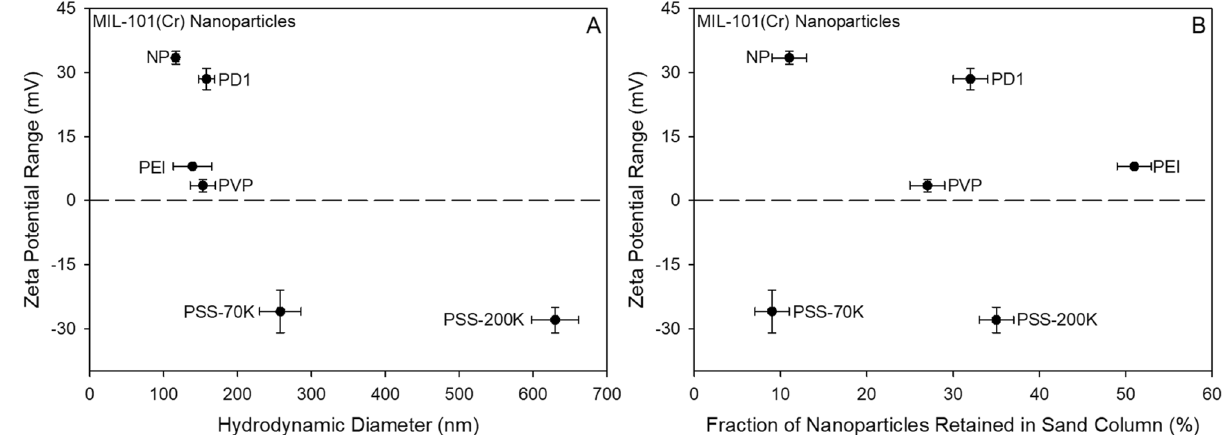
Figure 3. ( A ) Zeta potential ranges and hydrodynamic radii of synthesized MIL-101(Cr) MOF nanoparticles and polymer-coated MOF nanoparticles at an unadjusted pH of 5.5. ( B ) Results of flow-through